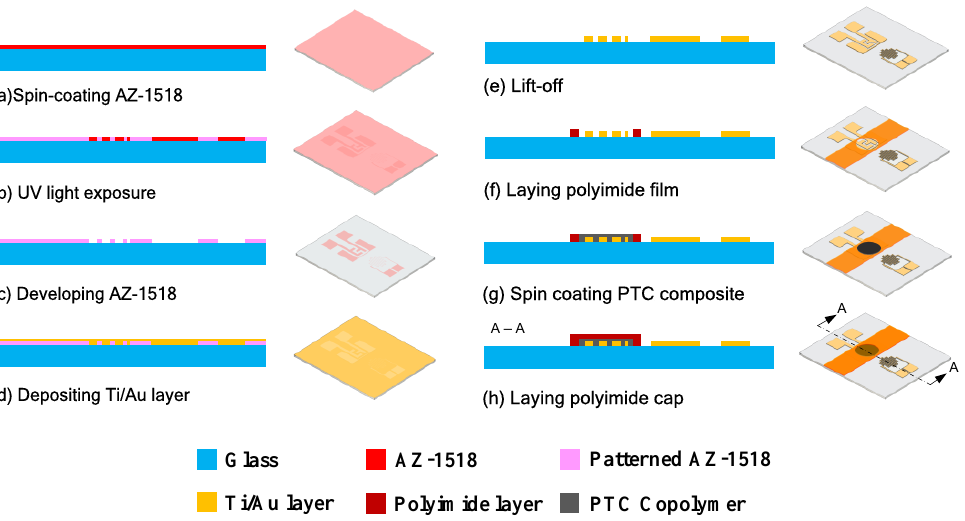
Figure 4. Fabrication process for the proposed thermal oscillator.